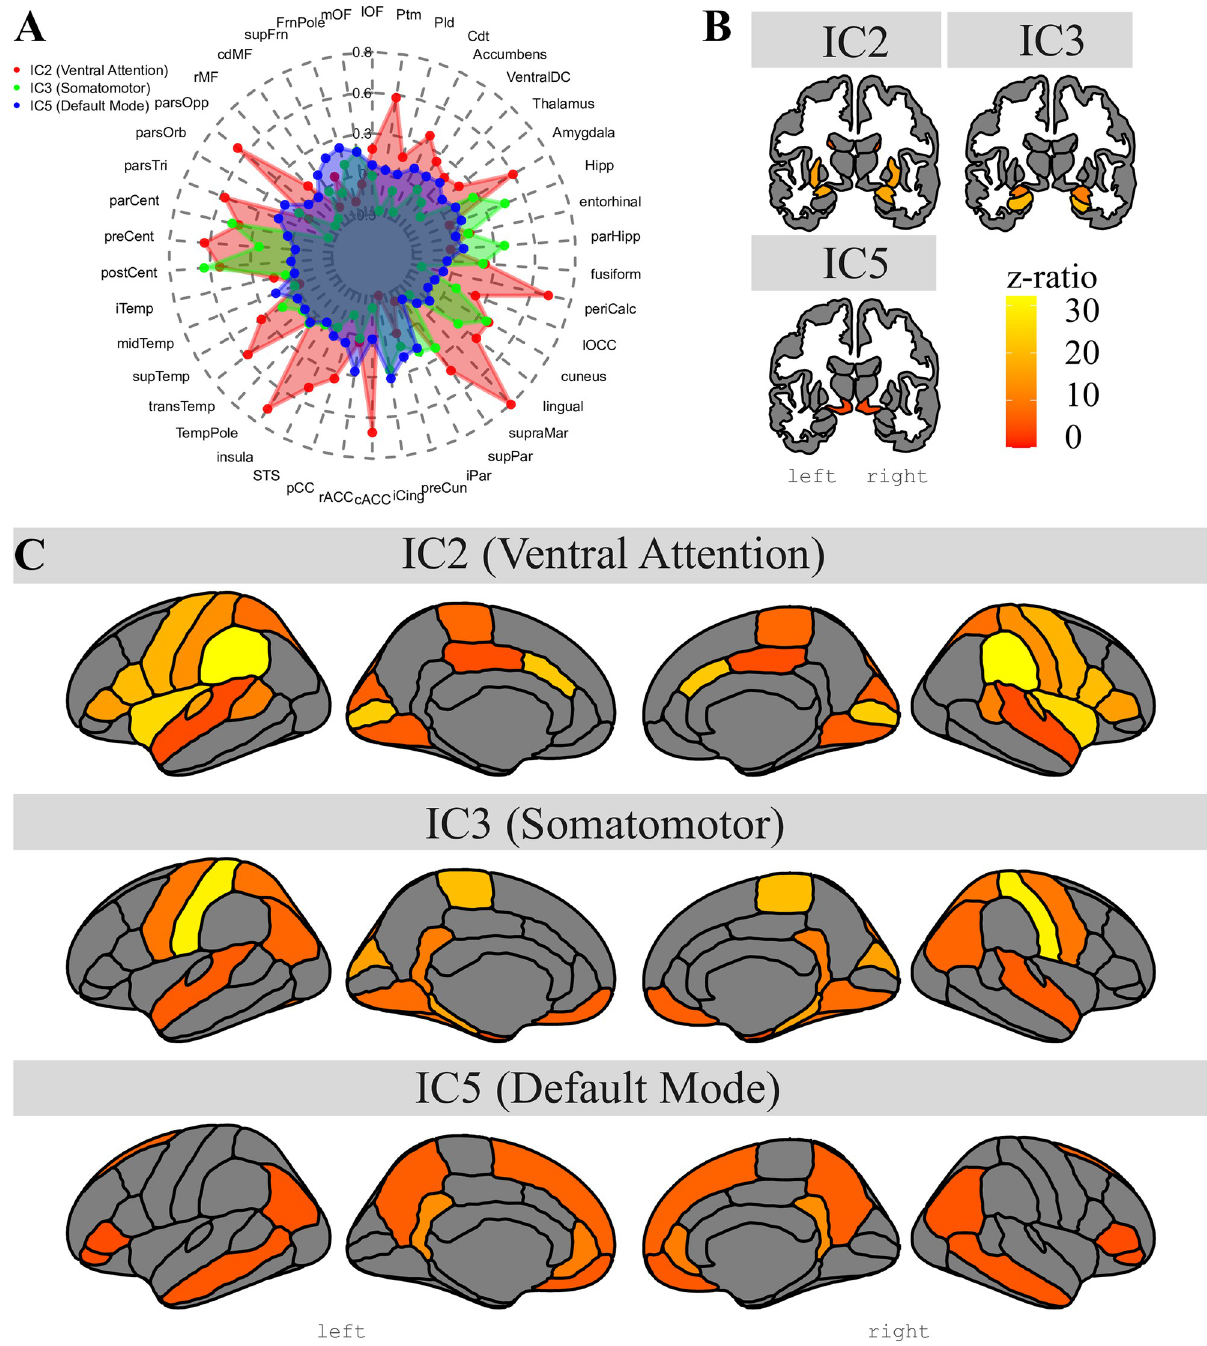
Fig 5. Results from group-level analyses for all ROIs. Representation of estimated marginal mean group-level FC values between IC hotspots inside the amygdala and each cortical and subcortical region using a spiderplot (A), as well as the z-ratios representing group-level FC between IC hotspots inside the amygdala and subcortical (B) and cortical (C) regions. Note how different hotspots of activity detected inside the amygdala are functionally connected with clearly different whole-brain networks.